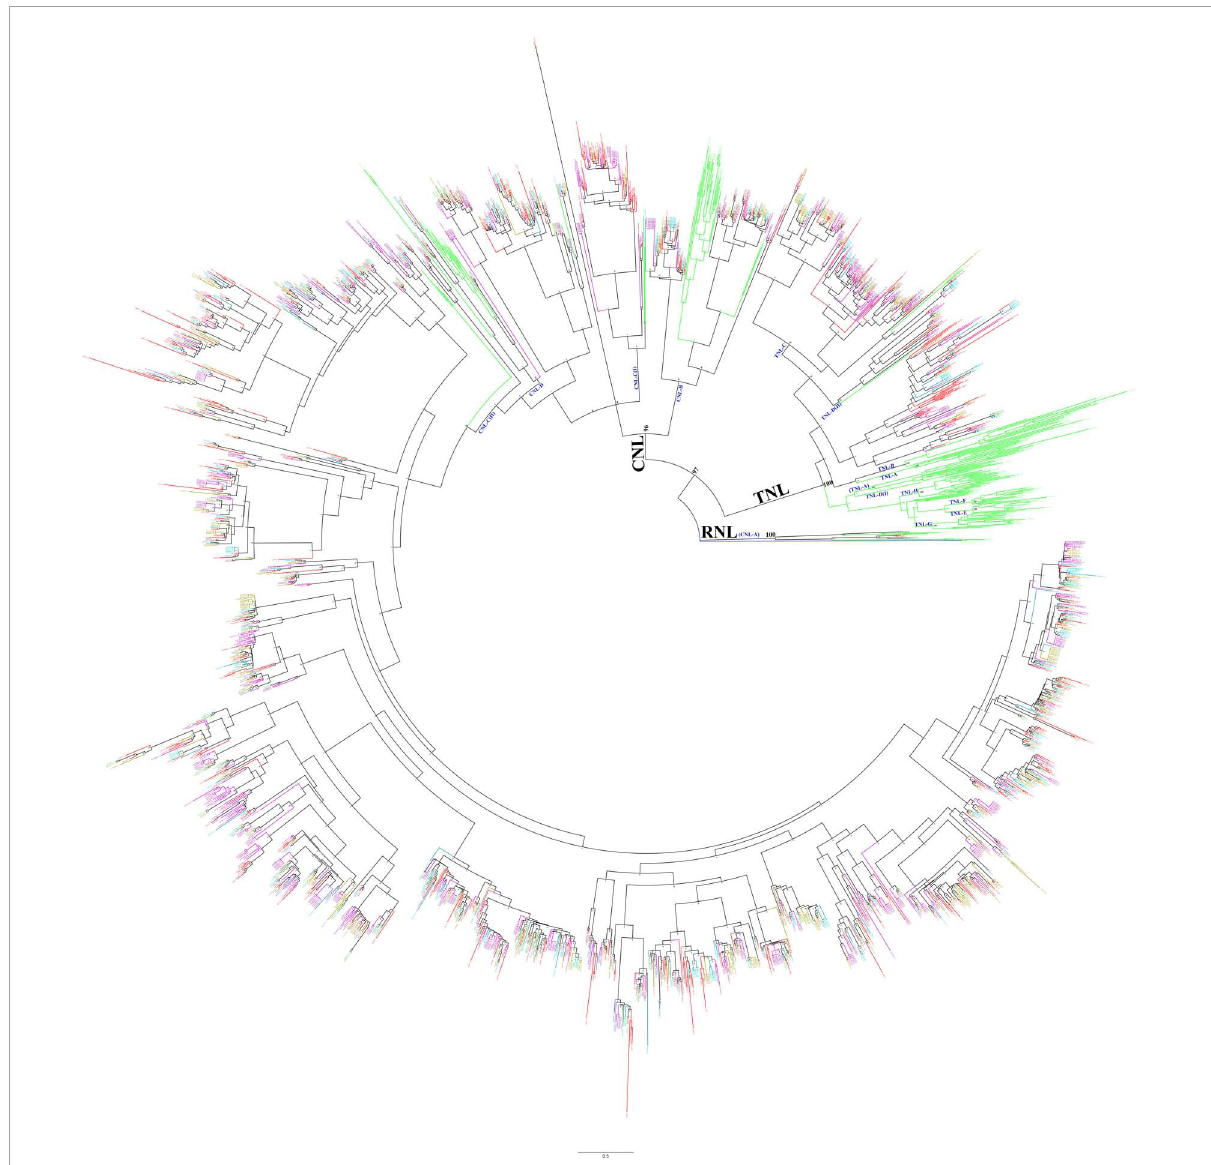
FIGURE2 Phylogenetic relationships of the nucleotide-binding site (NBS)-encoding genes in Ipomoea batatas , Ipomoea trifida , I. triloba , I. nil , and Arabidopsis based on the amino acids (aa) of conserved NBS domains. Red, cyan-blue, olive, purple, and green lines represent the NBS-encoding genes in I. batatas , I. trifida , I. triloba , I. nil , and Arabidopsis, respectively. P25941 was used as an outgroup (marked as blue). Subclades are named as CNL-A to CNL-D and TNL-A to